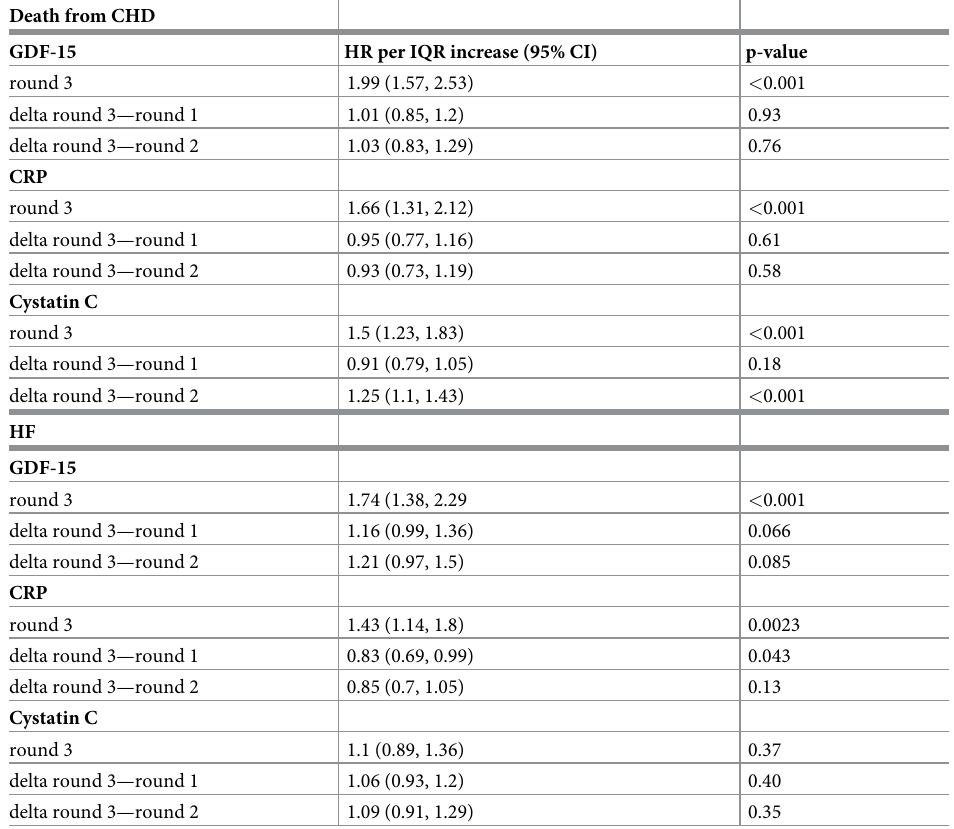
Table 3. Hazard ratios for Cox models with follow-up starting at round 3.